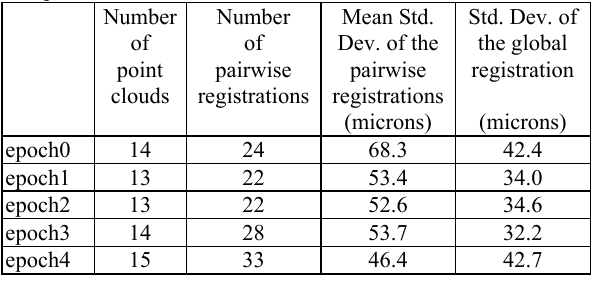
Table 2. Numerical results of the inner-epoch co-registration computations.